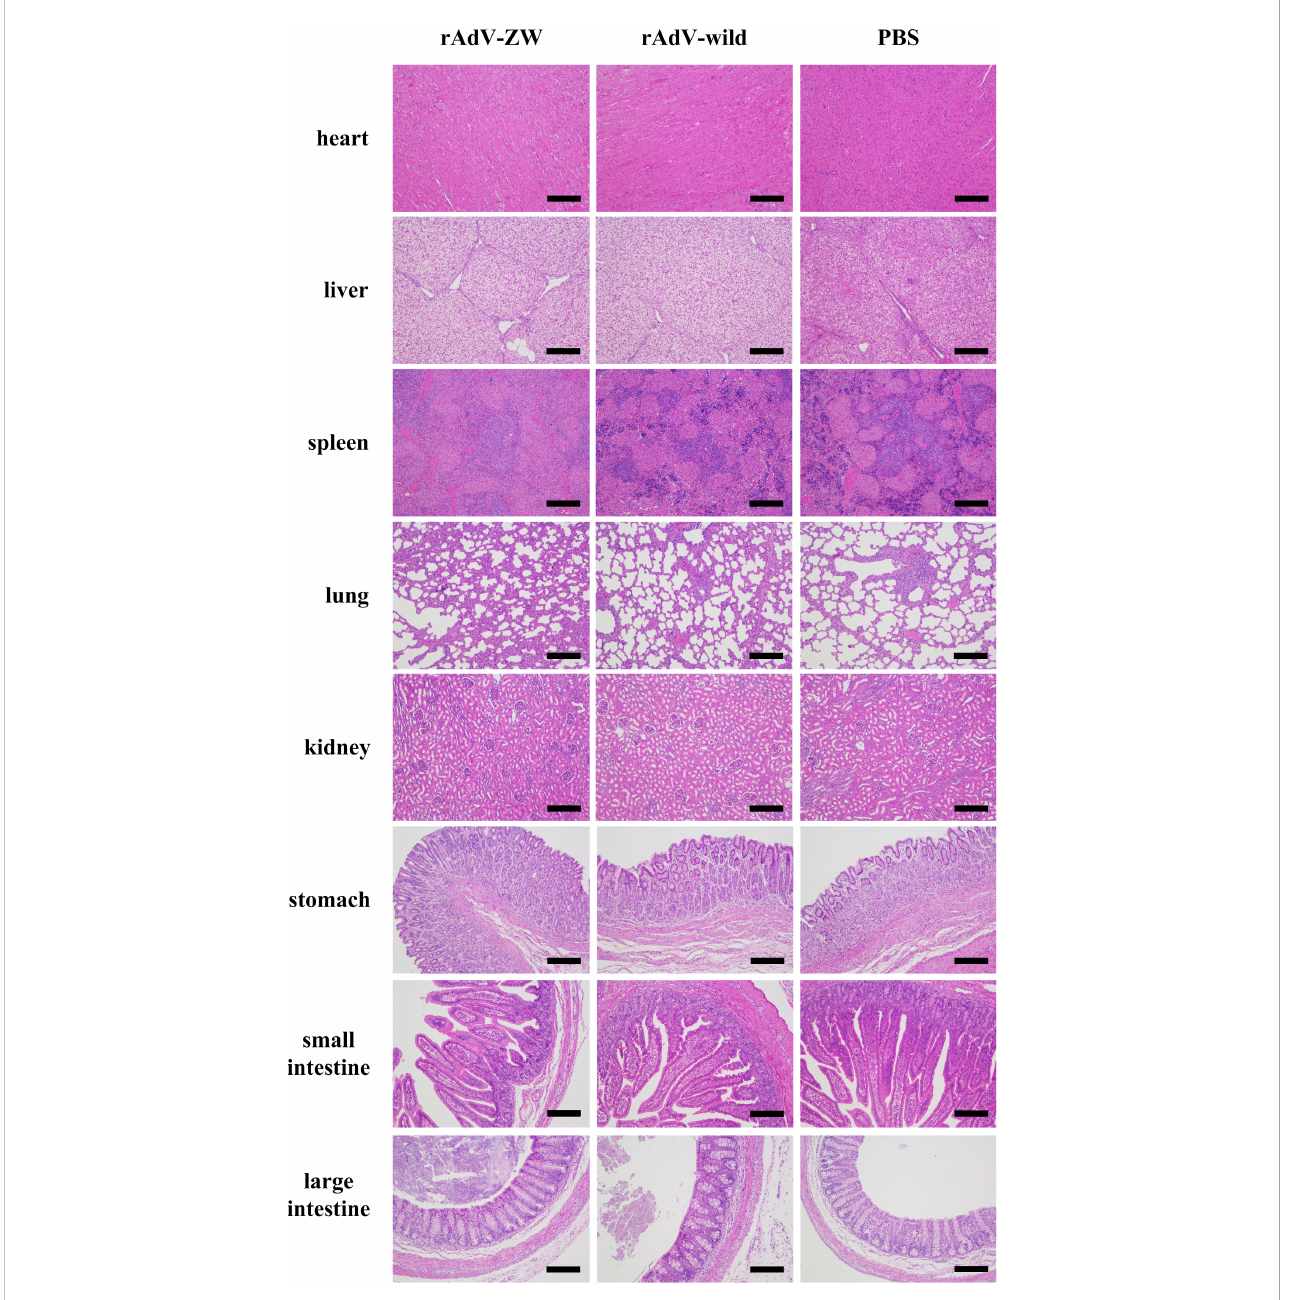
FIGURE 3 Histopathological analyses of different tissues after orally administrating rAdV-ZW, rAdV-wild-type, or PBS to piglets. Hematoxylin & eosin (H&E) staining of heart, liver, spleen, lung, kidney, stomach, small intestine, and large intestine. Scale bar = 200 m